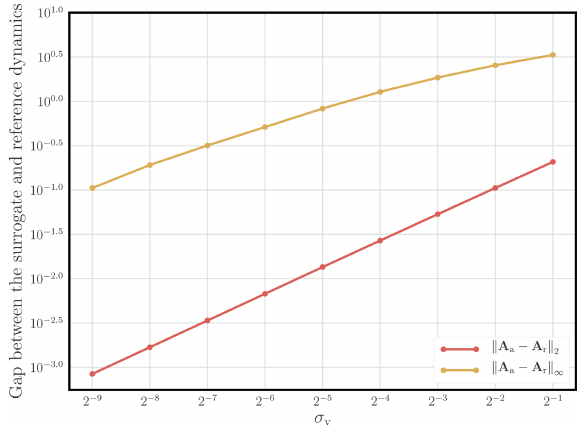
Figure 8. Gap between the surrogate (L96 with an RK4 structure) and the (identifiable) reference dynamics (L96 with an RK4 inte- gration scheme) as a function of the observation error standard de- viation σ y . Note the use of logarithmic